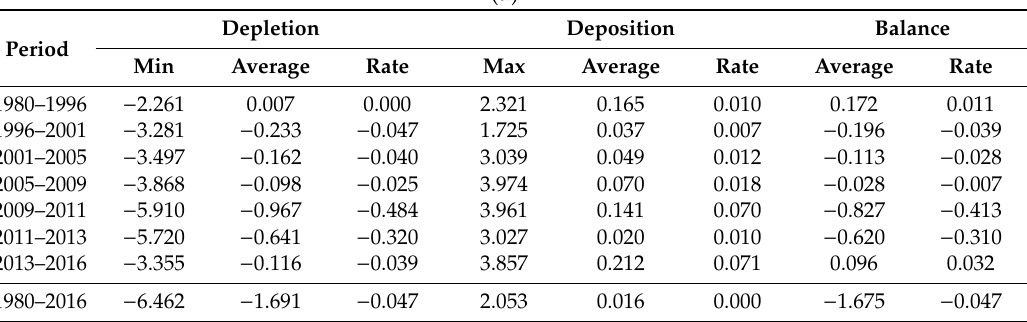
Figure 8. DTMs of di ff erences of the detailed area: ( a ) period 2009–2011; ( b ) period 2011–2013. Table 8. ( a ) Height di ff erences and rates in the gullies of the detailed area for DSMs 1,2 . ( b ) Height di ff erences and rates in the gullies of the detailed area for edited DTMs 1,2 . ( a